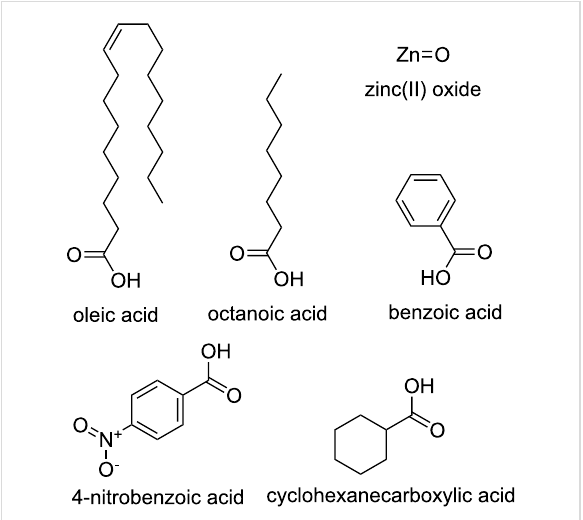
Figure 2: Chemical structures used to calculate the surface properties.